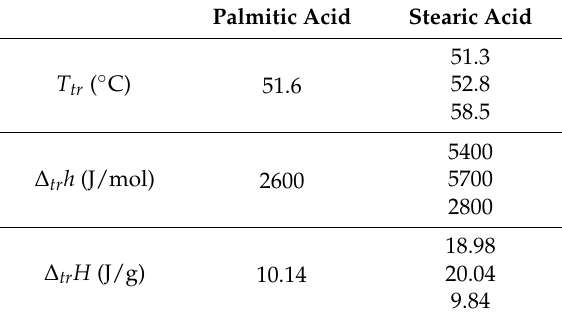
Table 2. Values of temperatures of transitions, molar enthalpies of transitions and mass molar enthalpies used in the model to take into account the polymorphic behavior of palmitic and stearic acids